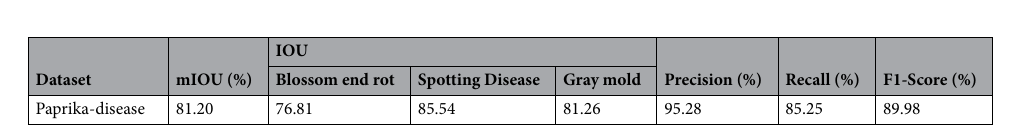
Figure 15. Qualitative results of proposed algorithm on Paprika Disease Dataset. ( a ) input image, ( b ) manual label, and ( c ) overlay of the generated label.